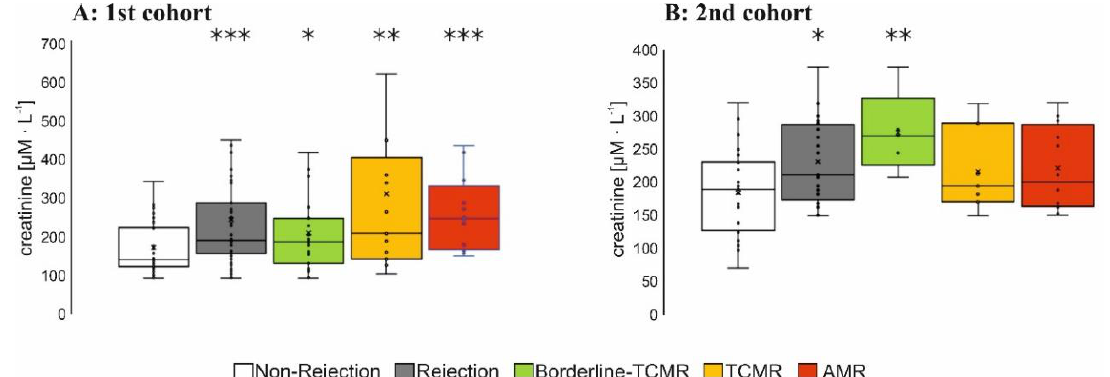
Figure 1. Serum creatinine of 1st ( A ) and 2nd patient cohort ( B ): Serum Creatinine was determined at the day of the protocol or for-cause-biopsy in kidney transplant recipients with non-rejection, borderline-TCMR, TCMR (T-cell mediated rejection) or AMR (antibody-mediated rejection) as indi- cated. Boxplots show the median value, the mean and the standard error of the mean. Wilcoxon test revealed a statistical significance between groups with * p < 0.05; ** p < 0.01; *** p < 0.001 as indicated.